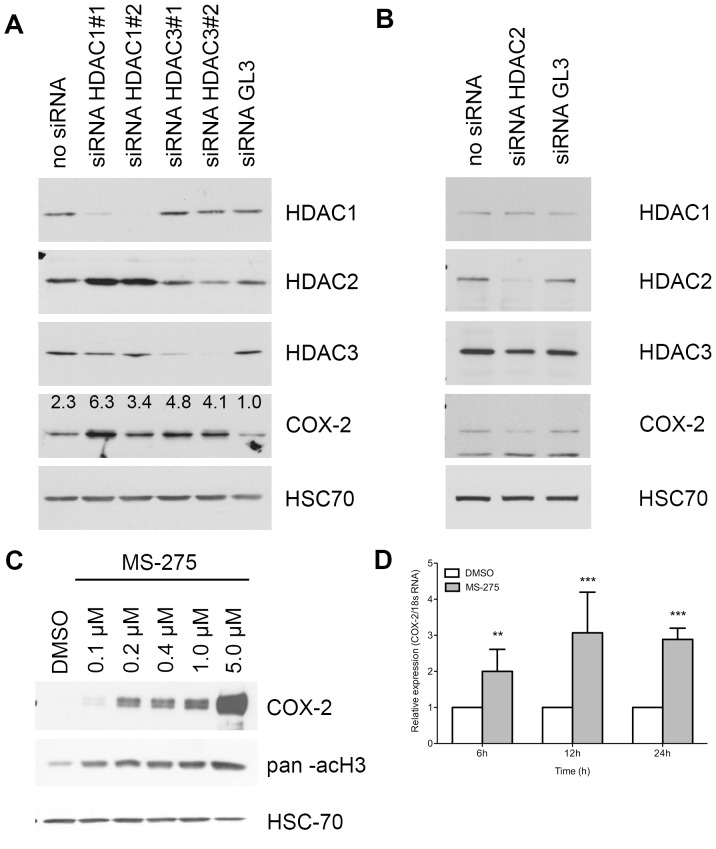
Effect of HDAC silencing or inhibition on COX-2 expression in BxPC-3 cells.(A) Western-blot detection of COX-2 and HDAC in 20 µg BxPC-3 proteins 48h after HDAC1 or HDAC3 siRNA transfection. (B) Western-blot detection of COX-2 and HDAC in 20 µg BxPC-3 proteins 48h after HDAC2 siRNA transfection. (C) Dose-dependent effects of 48h MS-275 treatment on COX-2 expression. Acetylated-histone H3 was used as a control of treatment efficacy. HSC70 was used as a loading control. (D) Time-dependent relative expression of COX-2 mRNA in BxPC-3 cells treated with 1 µM MS-275. Results are expressed as mean ± s.d., n = 3.